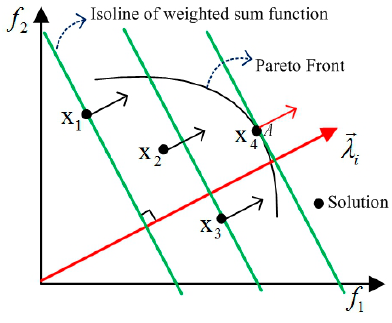
Figure 3. Solution selection in objective space based on the weighted sum technique.